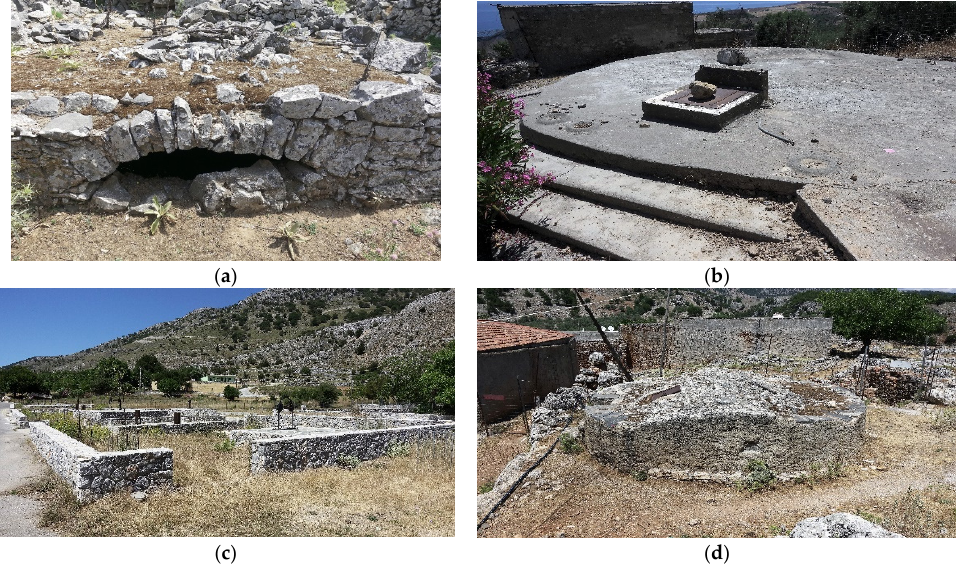
Figure 13. Water supply of Chora of Sfakia: ( a ) Venetian rainwater cistern and ( b ) costal spring (photos by A. N. Angelakis).